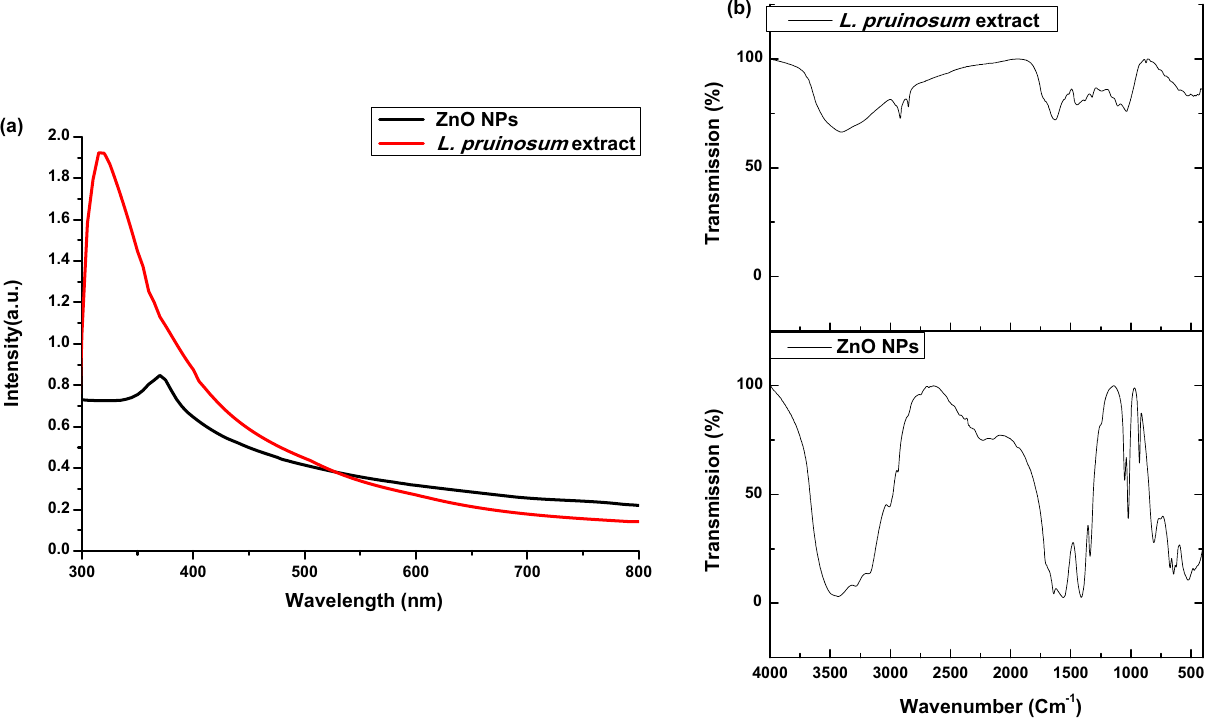
Figure 2. ( a ) UV–Vis spectrum; ( b ) FT-IR of L. pruinosum extract and the phytosynthesized ZnO NPs.